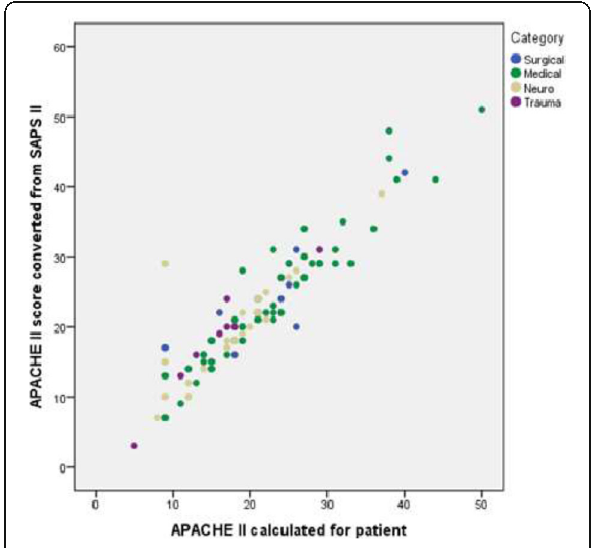
Fig. 1 (abstract 0034). ICC SAPS II - APACHE